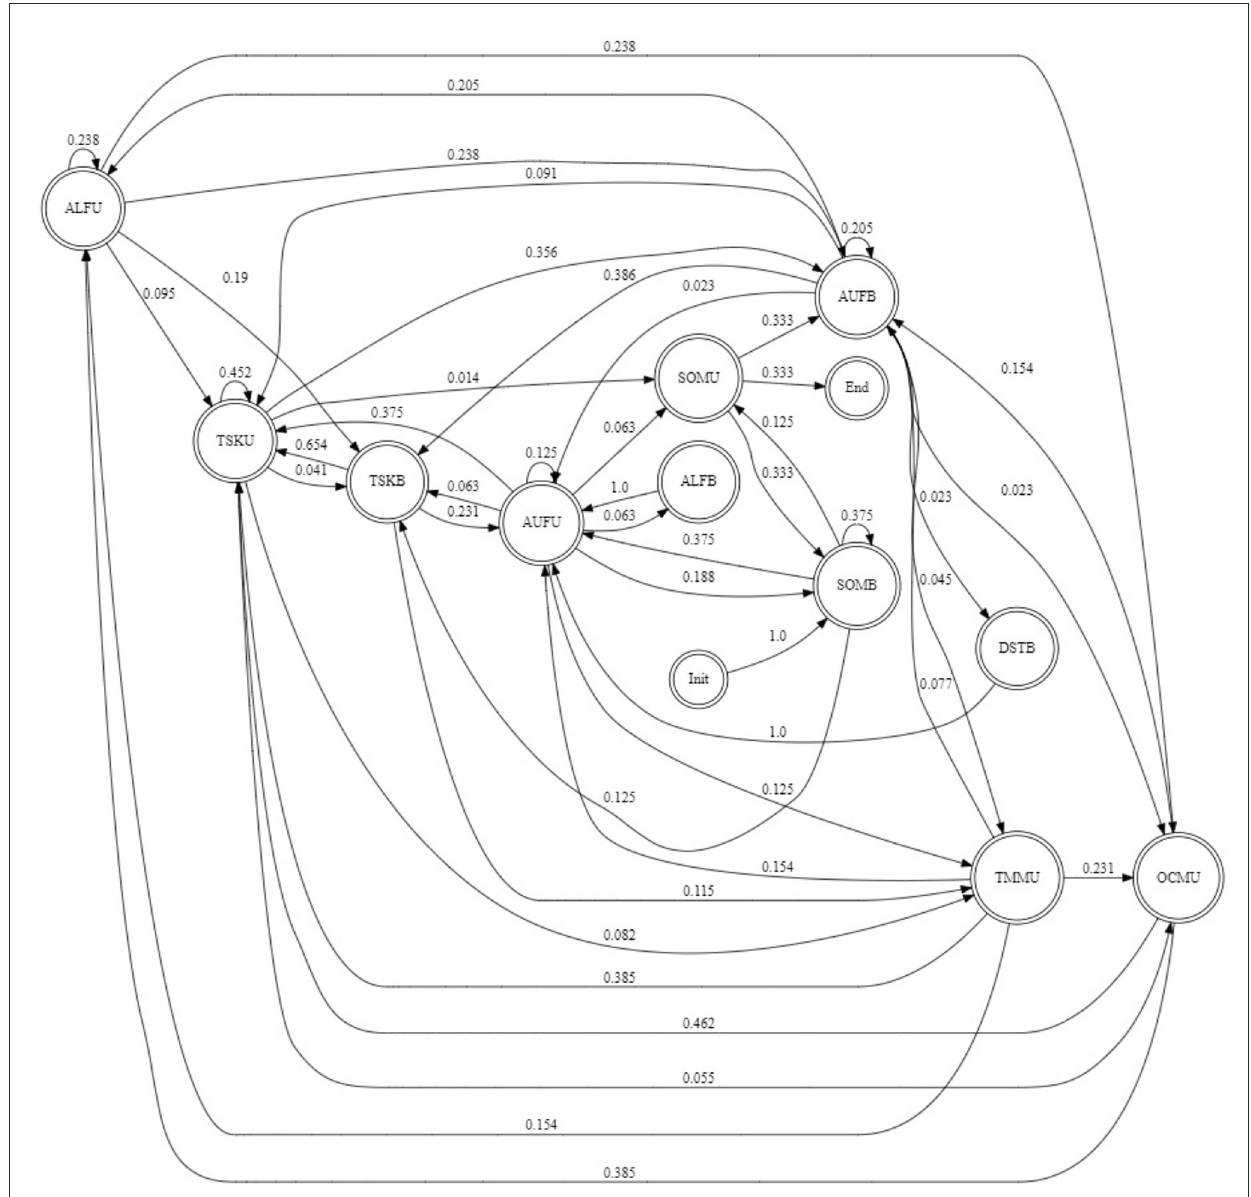
FIGURE1 Probabilistic finite state automaton generated from ISO 24617-2 annotated VICO dialog data. SOM, Social Obligation Management; TSK, Task; AUF, Auto-Feedback; ALF, Allo Feedback; DST, Discourse Structuring; TRM, Turn Management; TMM, Time Management; OCM, Own Communication management; B, Bot; U,